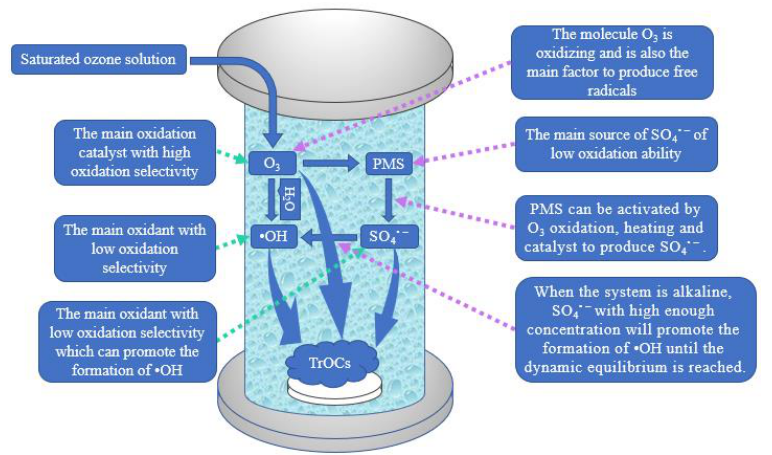
Figure 3. Main oxidants and catalytic processes in O 3 /PMS system.